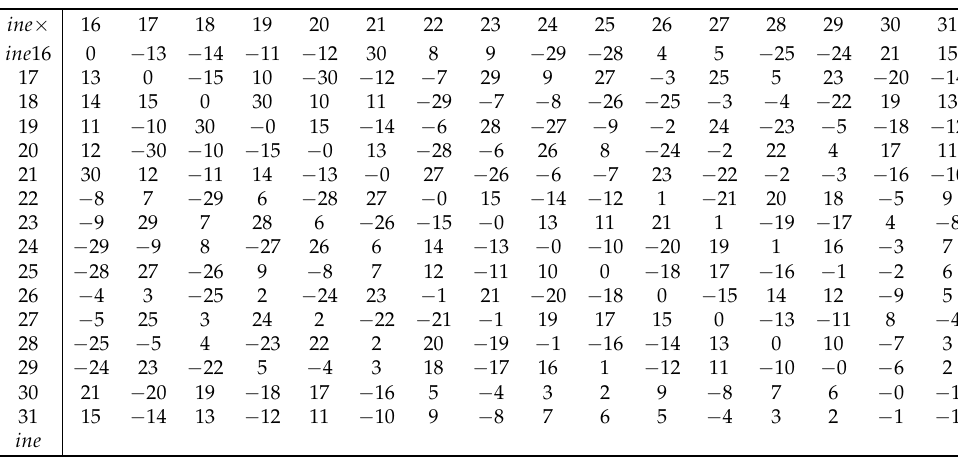
Table 4. Multiplication rules of Kaluza numbers for e 16 , e 17 , . . . , e 31 and e 16 , e 17 , . . . , e 31 (elements e i denoted by their subscripts, i.e., i = e i )